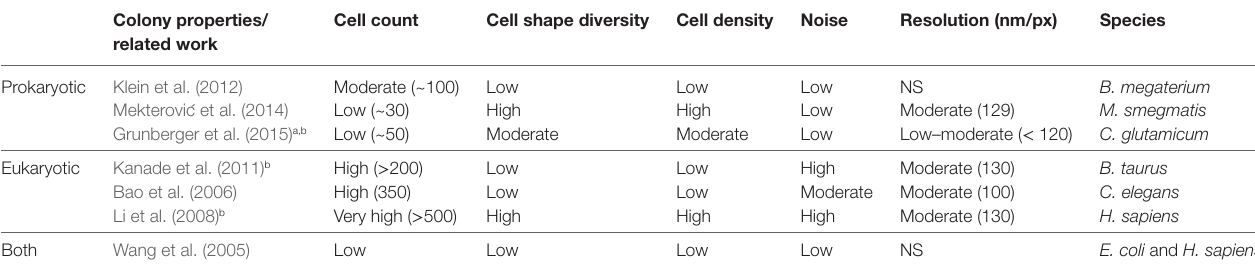
TaBle 1 | Related work is cataloged according to cell type and colony properties. colony properties/ related